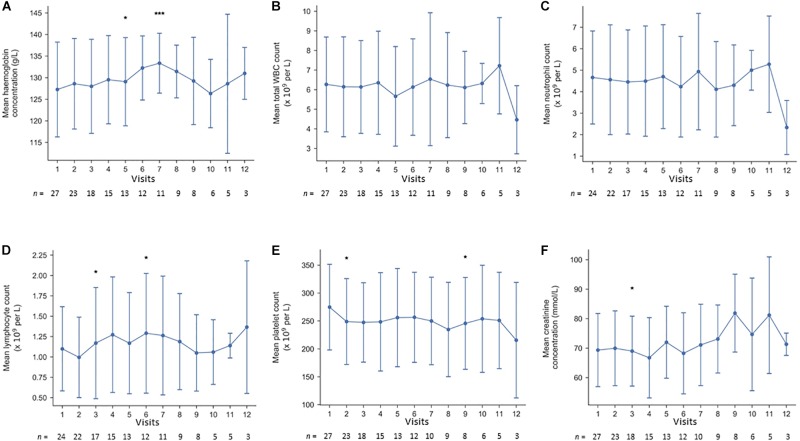
(A–F) Longitudinal laboratory safety data at the first 12 visits of the 27 cases; (A) hemoglobin, (B) white blood cell count, (C) neutrophil count, (D) lymphocyte count, (E) platelet count, and (F) plasma creatinine. ∗p < 0.05, ∗∗p < 0.01, ∗∗∗p < 0.005.